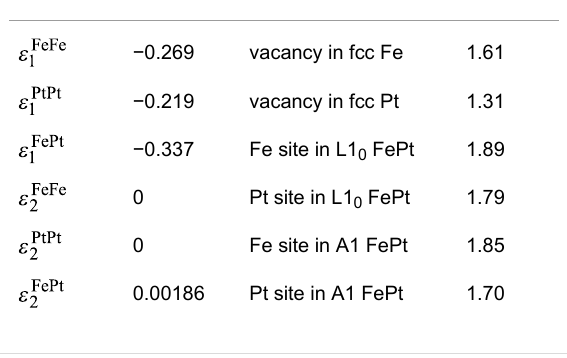
Table 1: Modified parameters of the Ising-type Hamiltonian of [9] and the resulting vacancy formation energies for various configurations.